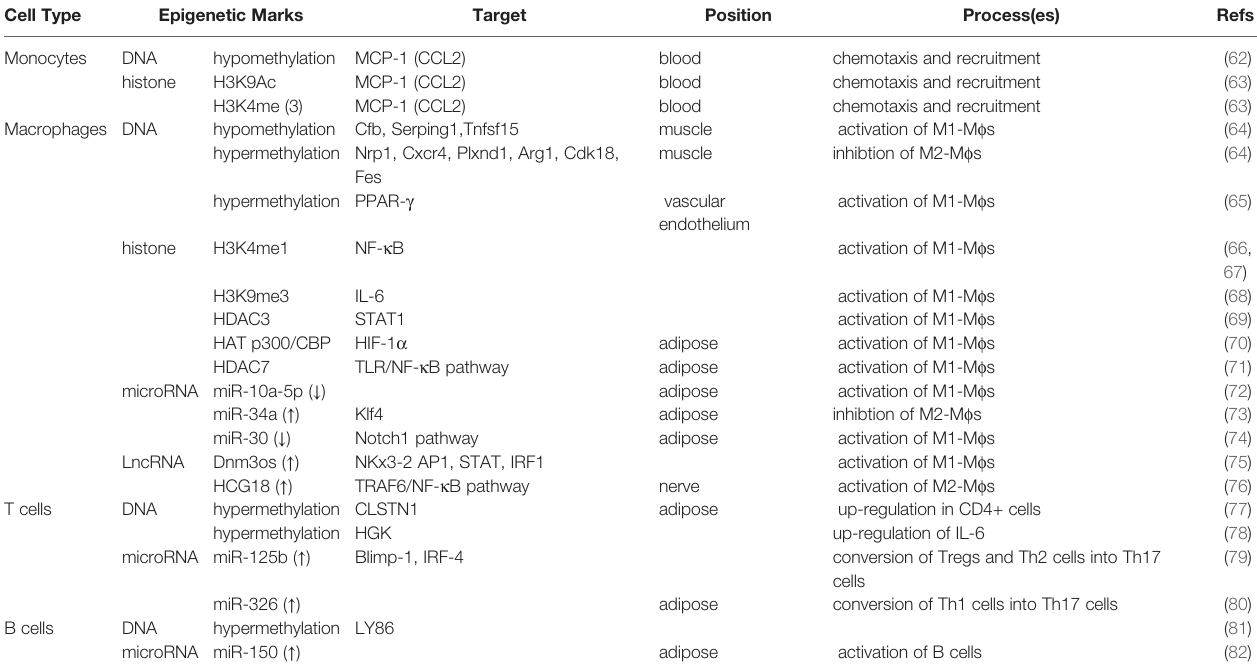
TABLE 1 | In fl ammation-related Epigenetic modi fi cation Involved in